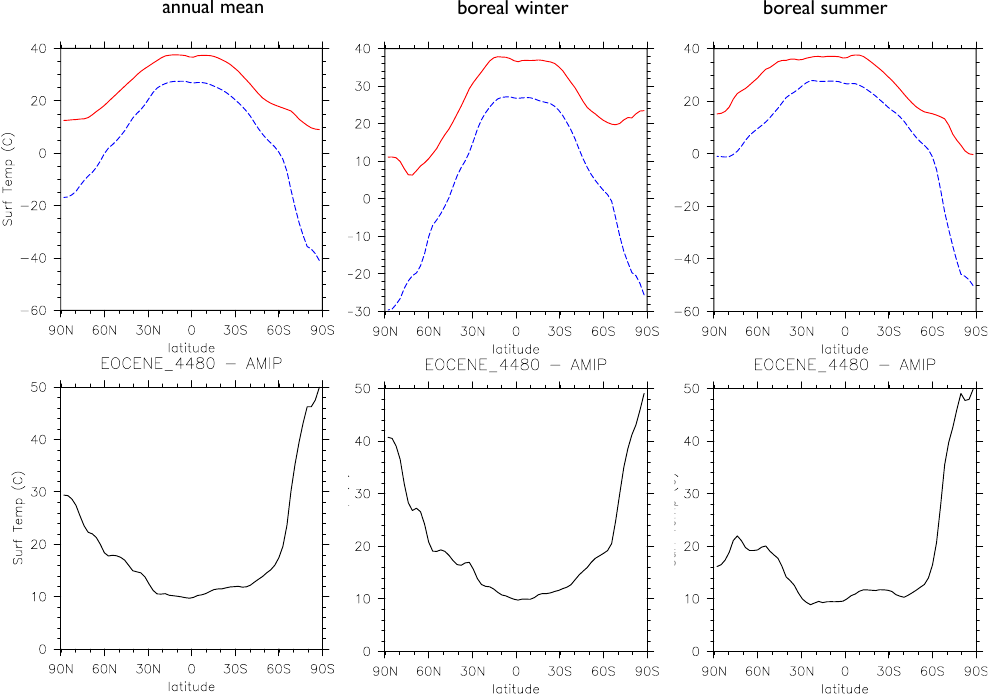
Fig. 2. Zonal mean surface temperature from the EOCENE-4480 (red) and modern, AMIP (blue) simulations as described in the text. In the upper row, the annual (left) boreal winter (middle) and boreal summer (right) means are shown. In the lower row, the anomaly, EOCENE-4480 minus modern, AMIP simulation is